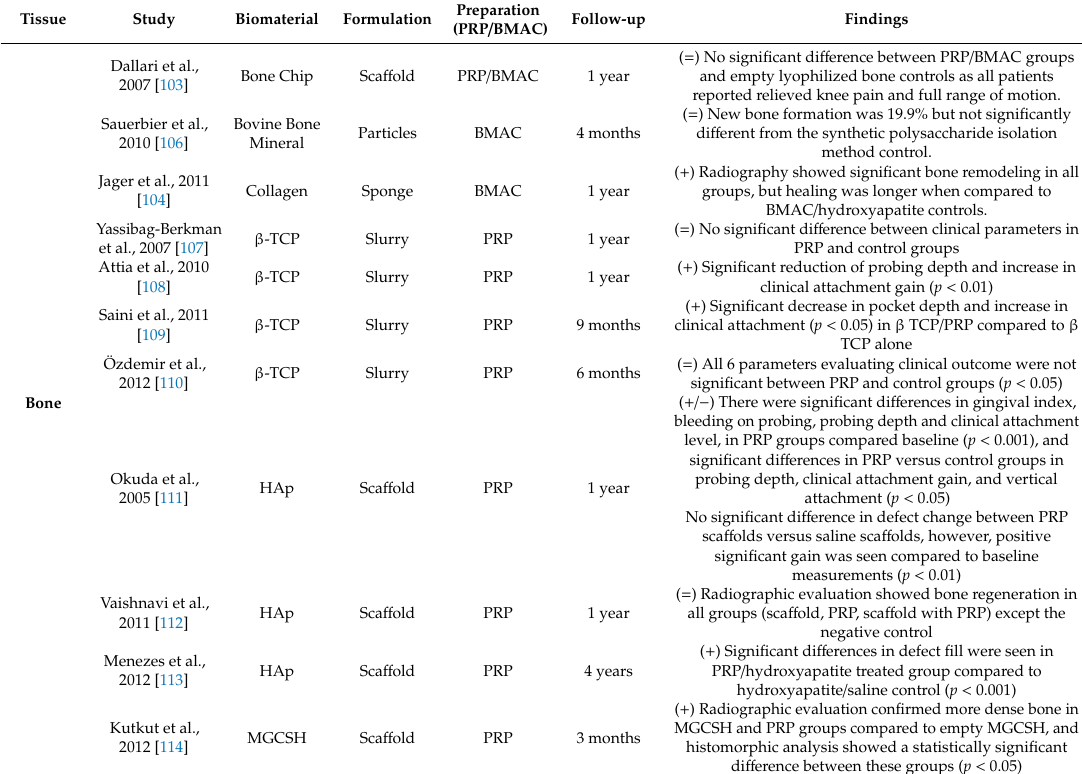
Table 3. Main biomaterials used with PRP and / or BMAC to treat cartilage and bone injuries.